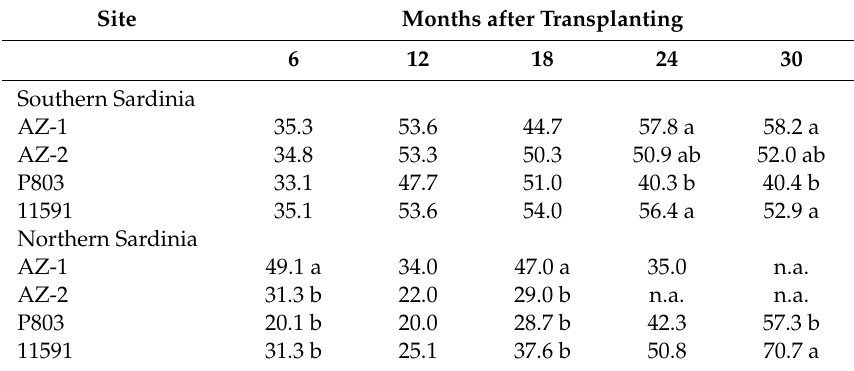
Table 2. Plant height (cm) of guayule lines from transplanting to harvest at 30 months at the two sites.